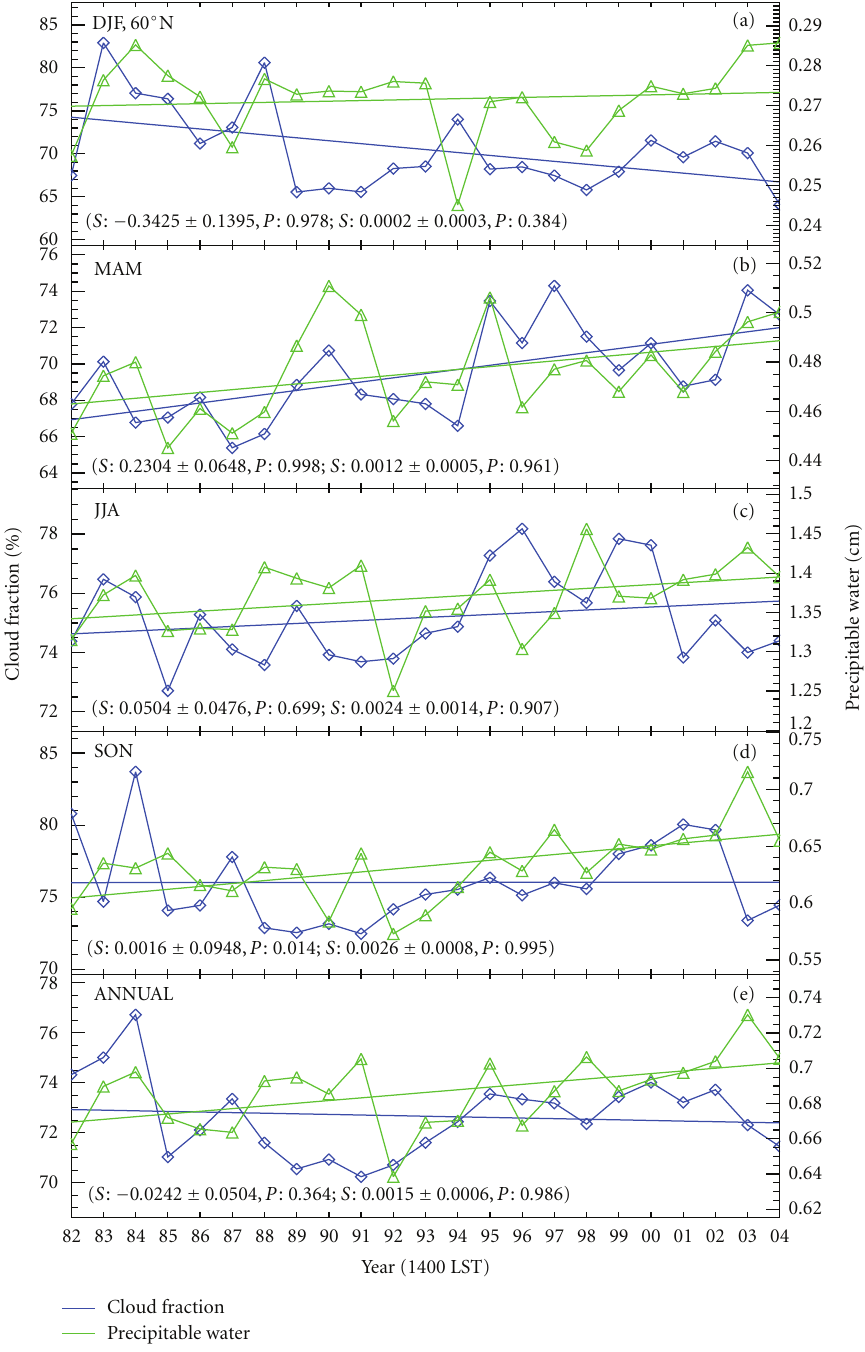
Figure 6: As in Figure 3 but for cloud fraction and precipitable water. The first pair of S and P denotes the cloud fraction trend (blue) and the second pair is for the precipitable water trend